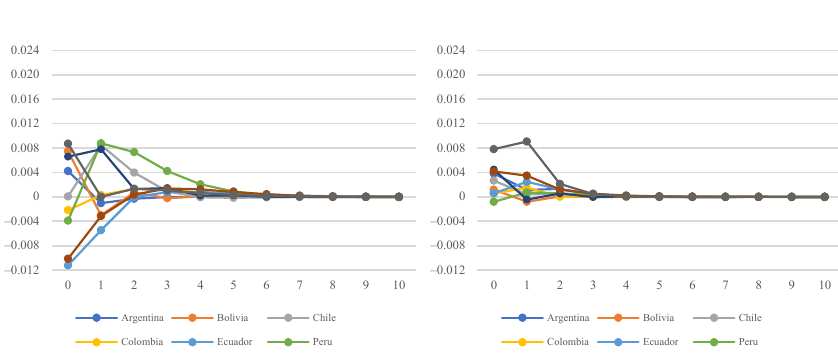
Figure 5. Response of domestic output to a global shock in CAC, 1960 – 2000 (left), 2001 – 2018 (right)